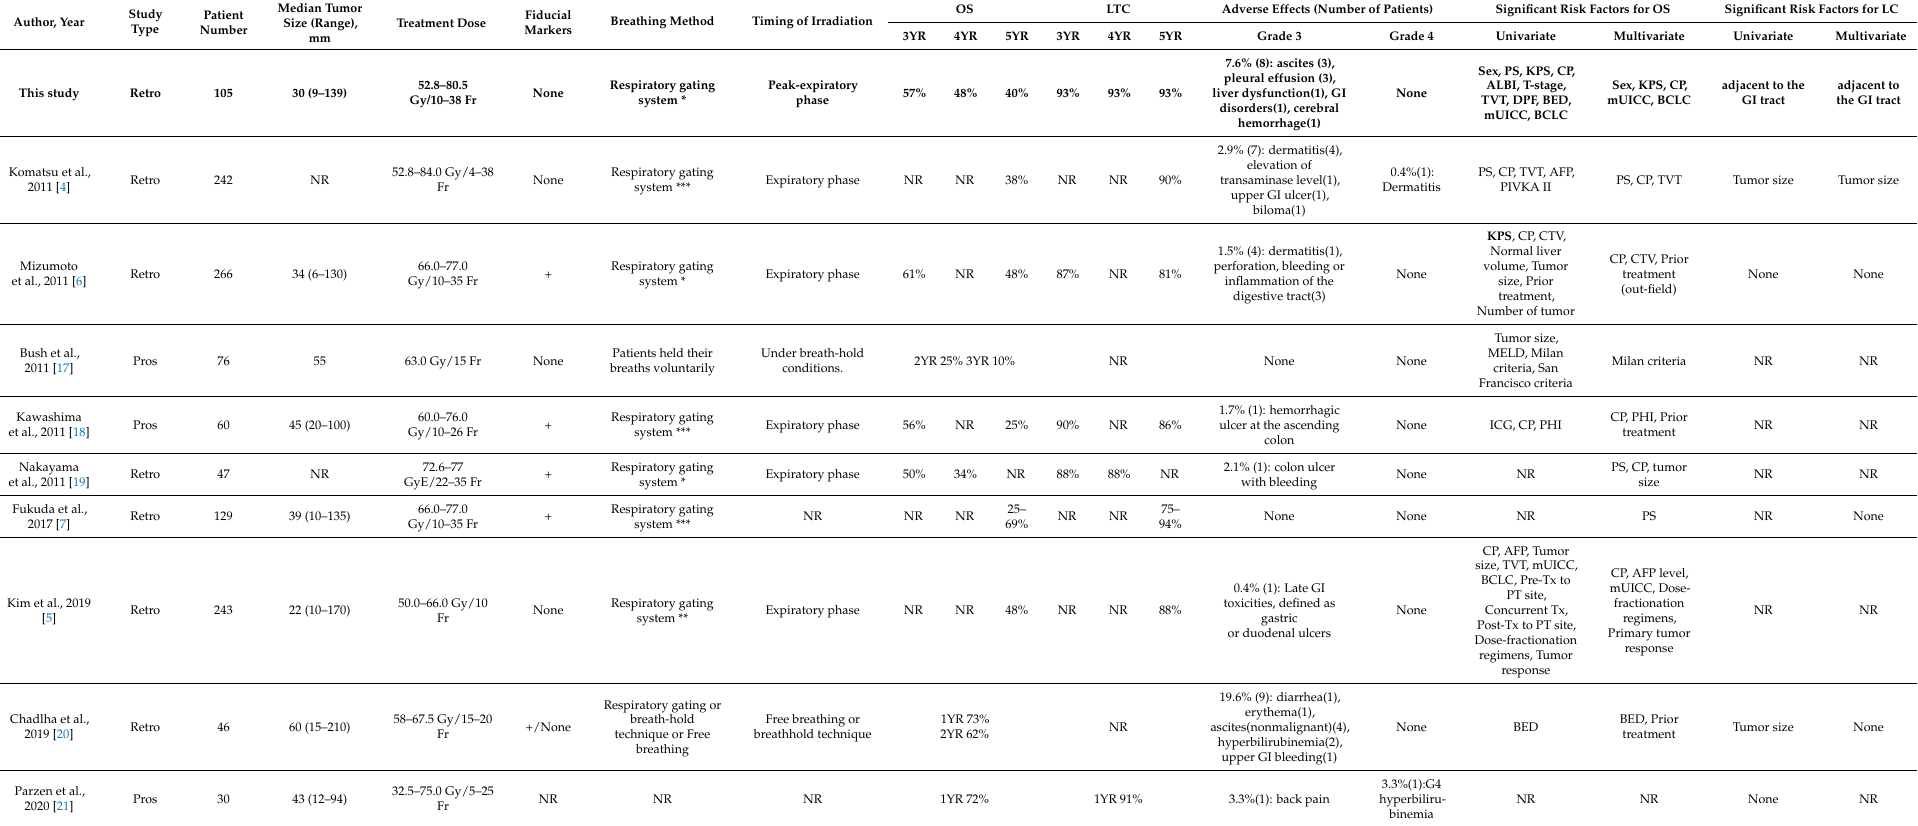
Table 5. Results of the present and other studies on proton therapy for HCC.